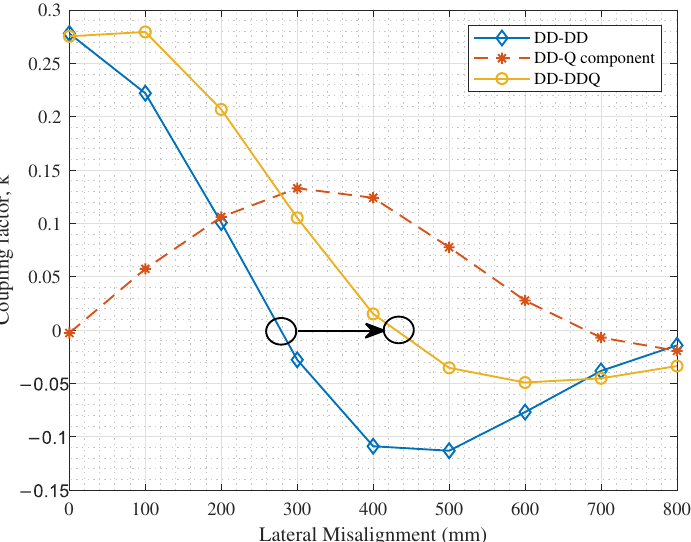
Figure 16. Extended positive coupling range as a result of adding a quadrature coil to the sec- ondary